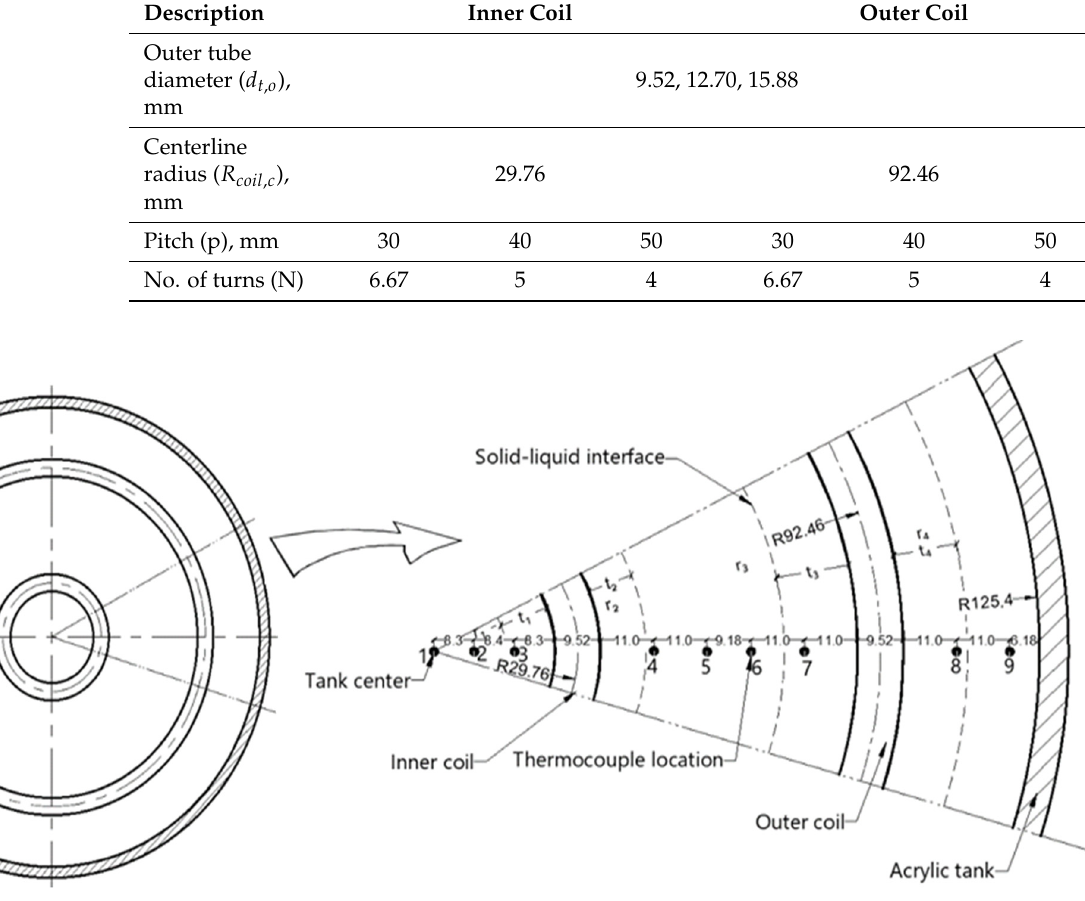
Figure 2. Positions of thermocouples on the horizontal plane at the mid-turn of TCHC